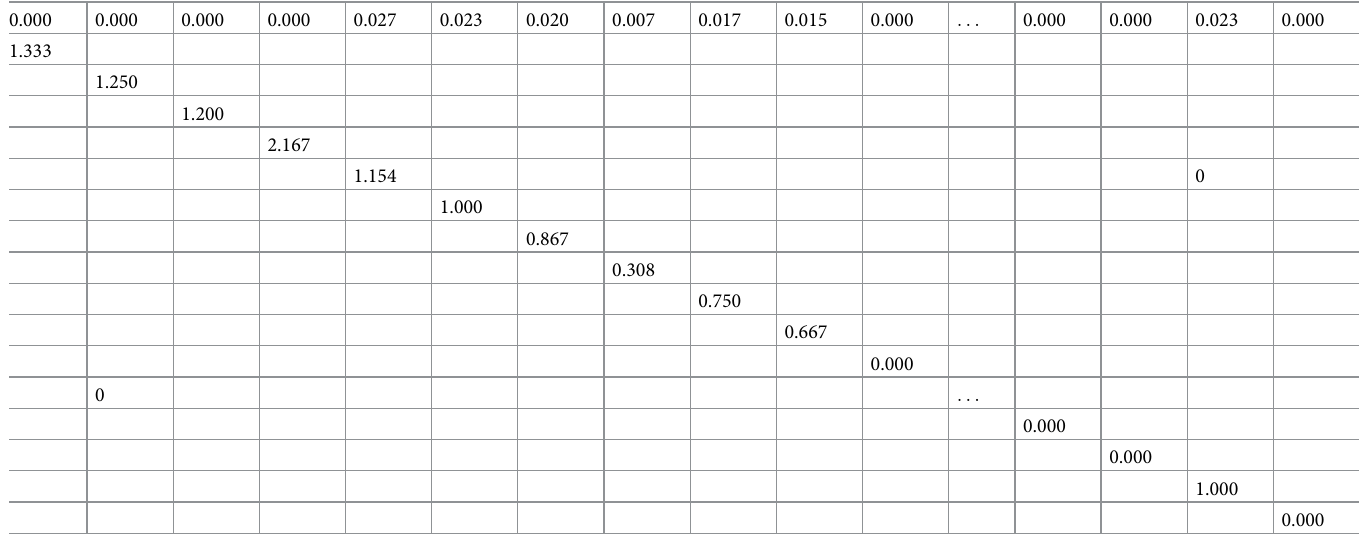
Table 10. Leslie matrix model of P . flavus LM population.